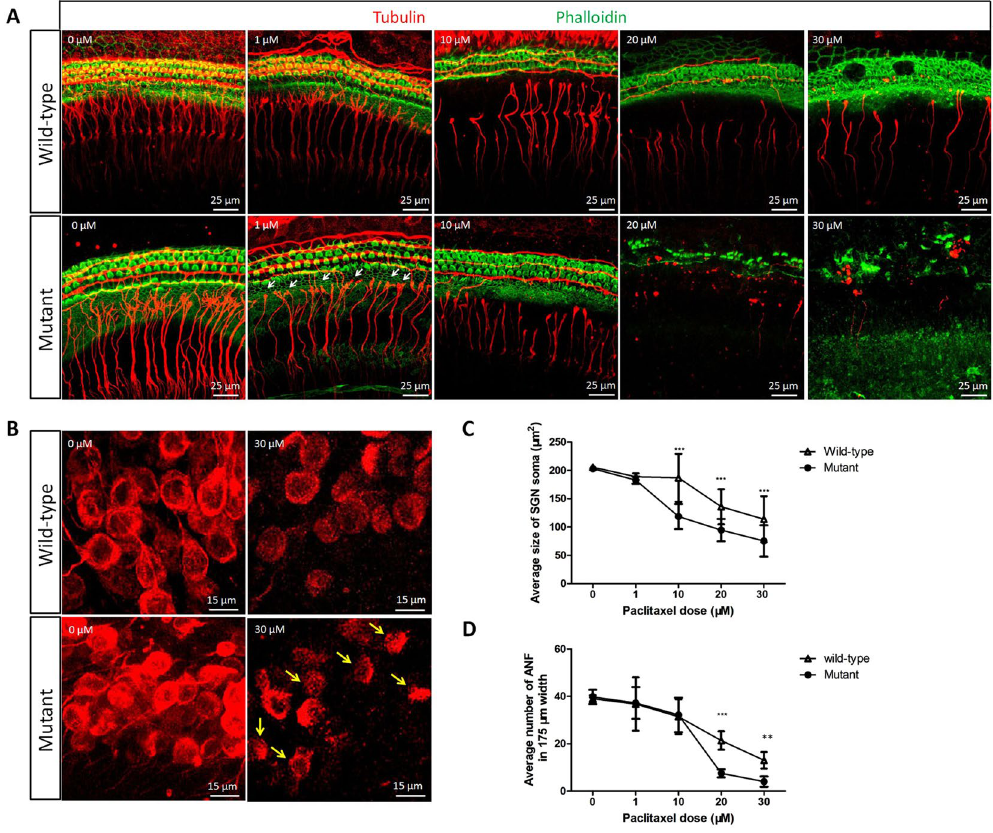
Figure 8. Higher sensitivity of Spag6 mutant SGNs to paclitaxel ( A ) Photomicrographs show SGN organotypic cultures from the upper basal turn of the cochlea after 48 hours of treatment with paclitaxel; concentration is shown in each panel. The mutant and wild-type auditory nerve fibers (ANFs) extending radially toward the hair cells at 0 μ M. Note that, although there was no statistic difference in ANF number and soma size at 1 μ M, swelling terminals of ANFs can be seen in the mutant SGN (white arrows) while it was not obvious in the wild- type group; at 10 μ M, although the number of ANF is the same, the length of mutant ANF has changed a lot and become much shorter, the terminals of the ANF were far from hair cells according to the observation. And at the same time the soma size decreased, the size of SGN soma were much smaller in the mutant mice (C, wild- type, 186.8812 ± 42.44, n = 86; mutant, 118.7140 ± 22.06, n = 60; P < 0.001). Loss of ANFs as dose increases from 20 μ M to 30 μ M, the mutant conserved less ANF number (20 μ M: wild-type, 21.3333 ± 3.88, n = 6; mutant, 7.5000 ± 1.73, n = 4; P < 0.001; 30 μ M: wild-type, 13.0000 ± 3.46, n = 6; mutant, 4.0000 ± 2.16, n = 4; “n” indicates SGN explant number; P < 0.01) and smaller soma size wild-type (20 μ M: wild-type, 135.8365 ± 30.92, n = 41; mutant, 94.5951 ± 19.73, n = 82; P < 0.001; 30 μ M: wild-type, 113.8856 ± 40.64, n = 31; mutant, 75.5018 ± 27.78, n = 99; “n” indicates SGN soma number; P < 0.001) than those of the wild-types, and the differences were significant ( D ). ( B ) Representative photomicrographs of normal SGN with large, round, densely package SGN. At 30 μ M paclitaxel the mutant showed more condensed SGNs (yellow arrows) and decreased number of SGN than those of the wild-type mice. * P < 0.05, ** P < 0.01, *** P < 0.001. Comparisons between two groups in the same drug dose were tested by Student’s